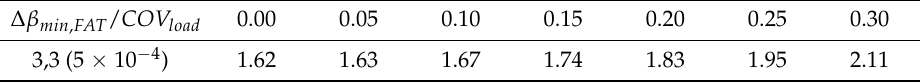
Table 4. Indicative partial safety factors γ f γ m as function of COV for fatigue